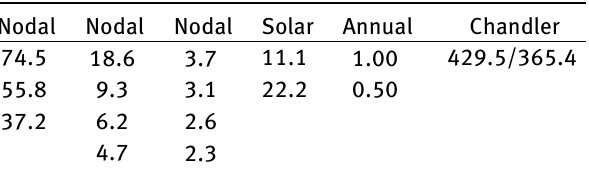
Table 2: Compounded periodicities (yr) of Luni-Solar origin incorpo- rated into the